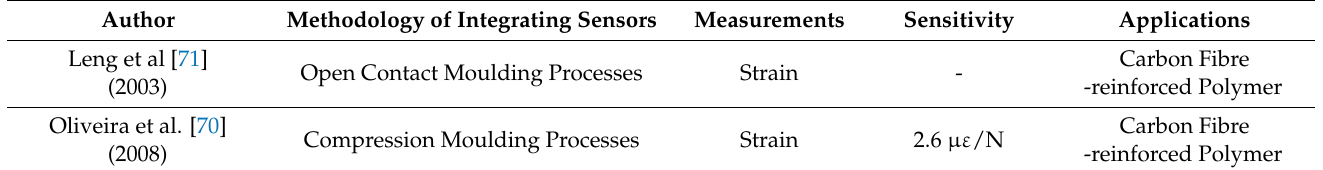
Table 3. Overview of applications and methodology of integrating both Fibre Bragg grating (FBG) Sensors and Extrinsic Fabry–Perot Interferometers (EFPI) for composite structural